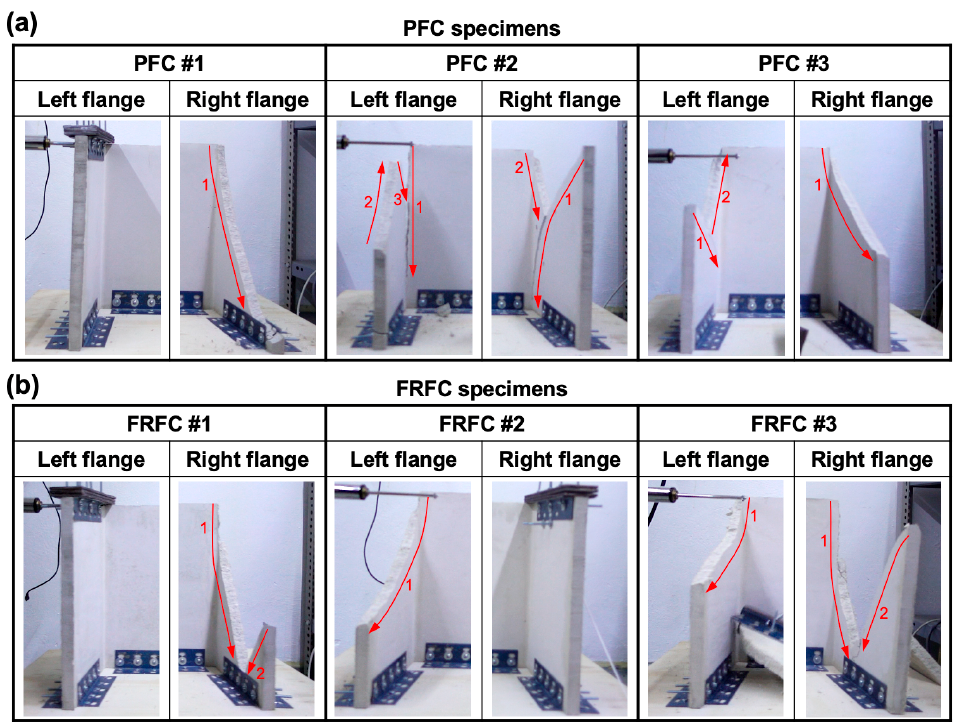
Figure 11. Failure modes observed during the shaking table tests of: ( a ) PFC specimens and ( b ) FRFC specimens.